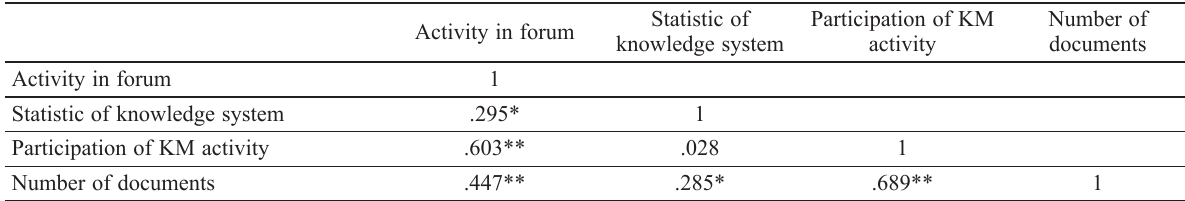
Table 9. The correlation matrix of objective factors